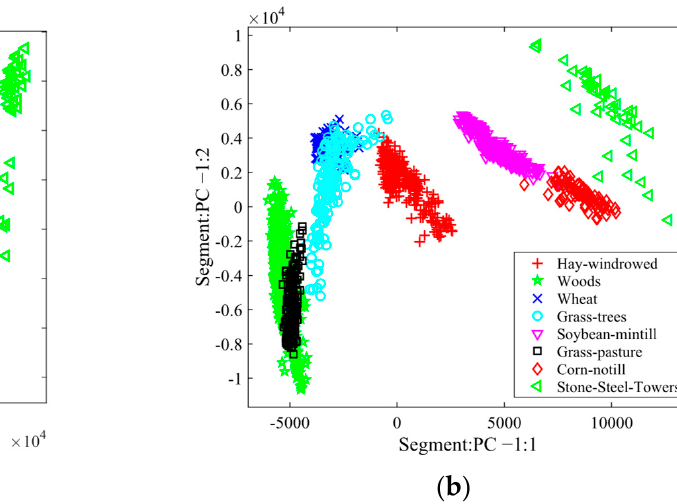
Figure 6. Overall classification accuracy on the HYDICE dataset.